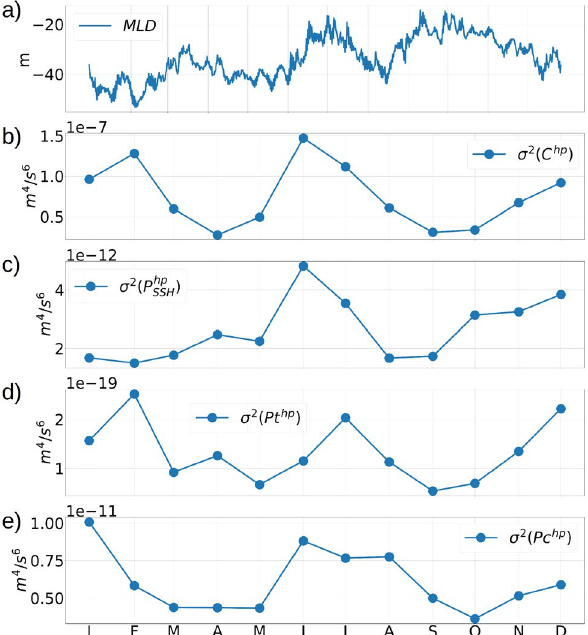
Figure 11. ( a ) The MLD averaged over the zonal transect A to the west of St Thomas (transect A shown in figure S5, supplementary material). Plots ( b ), ( c ), ( d ) and ( e ) show the spatial variances ( σ transect A for the high-pass filtered depth-averaged conversion term C hp , and the pressure transport terms P hp P hp t and P hp c respectively. The variances are calculated over transect A at every instantaneous time, and SSH , then averaged over each of the 12 months. The monthly averaging was done to show the seasonal variability